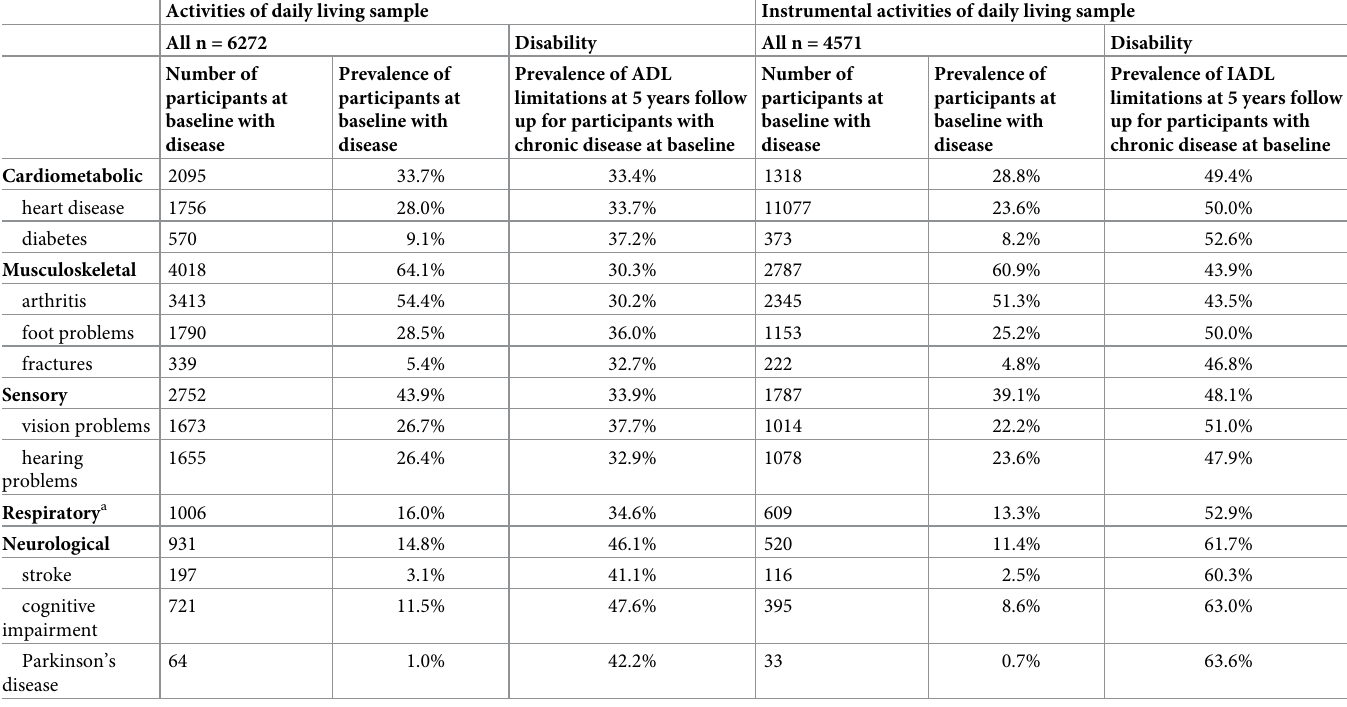
Table 2. Prevalence of activities of daily living and instrumental activities of daily living limitations at five years of follow up for participants with chronic diseases at